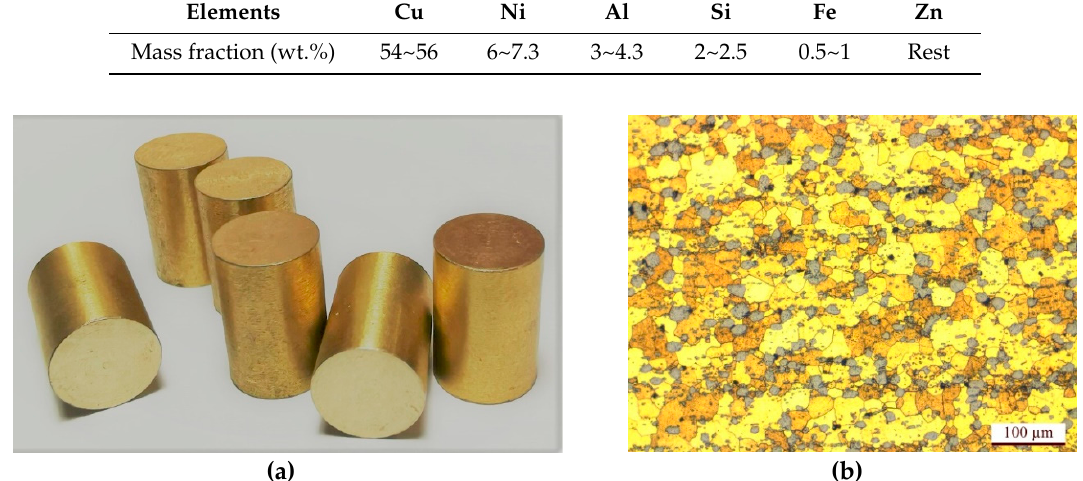
Figure 1. ( a ) Cu-Ni-Al nickel brass cylinders. ( b ) The microstructure of Cu-Ni-Al nickel brass before hot compression tests.